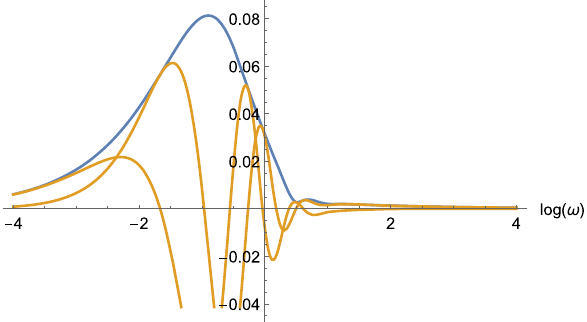
Fig. 1 The plot of absolute value (blue), real and imaginary parts (orange) of G (ω, 1 ) for the five dimensional parabolic case Table 1 The three different solutions in 4d hyperbolic case were found in